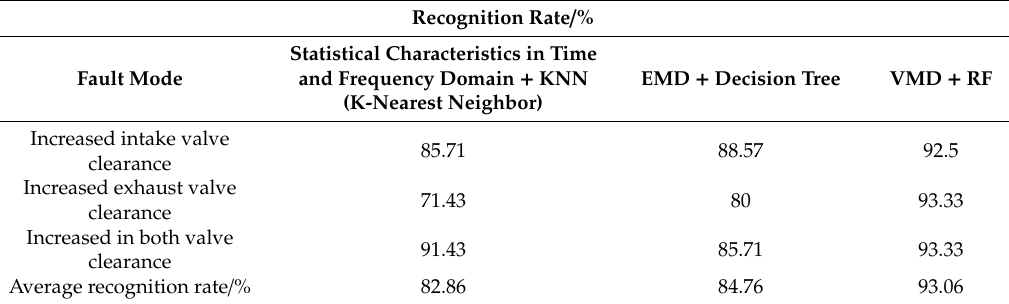
Table 8. Comparison of di ff erent fault diagnosis